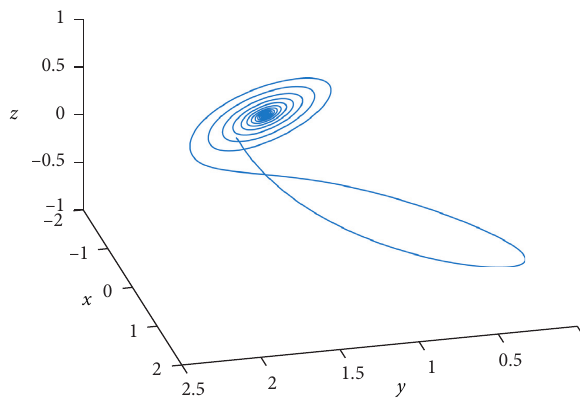
Figure 10: Dynamic behavior of fractional financial chaotic model with α � 0 . 95.